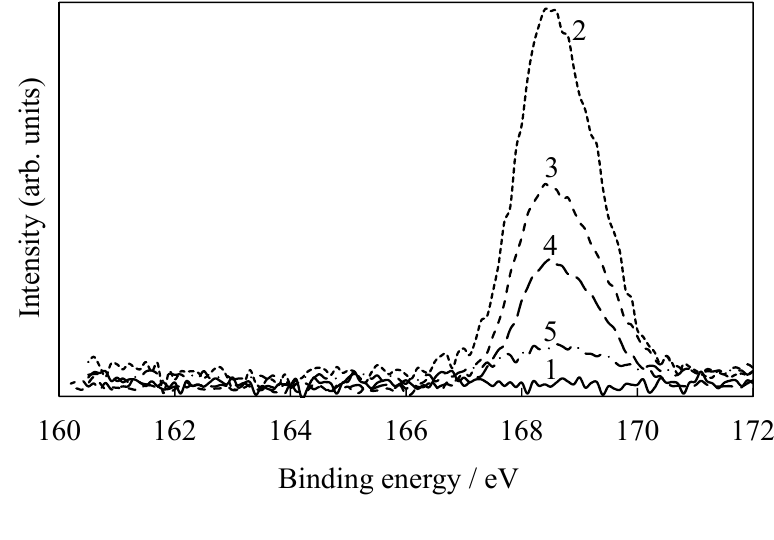
Figure 5. S 2p XPS spectra of (1) Sample T; (2) Sample S0; (3) Sample S300; (4) Sample S400 and (5) Sample